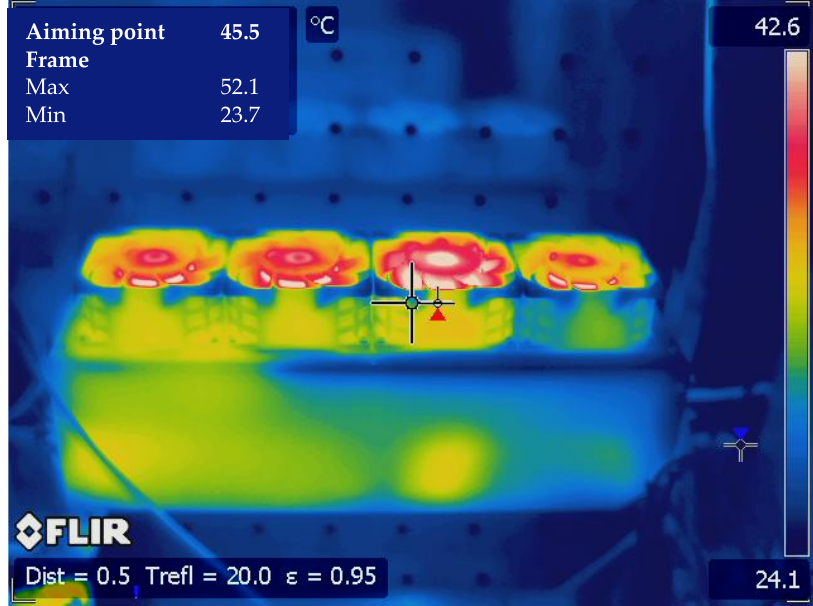
Figure 10. Thermal imaging of PEMFC during testing.